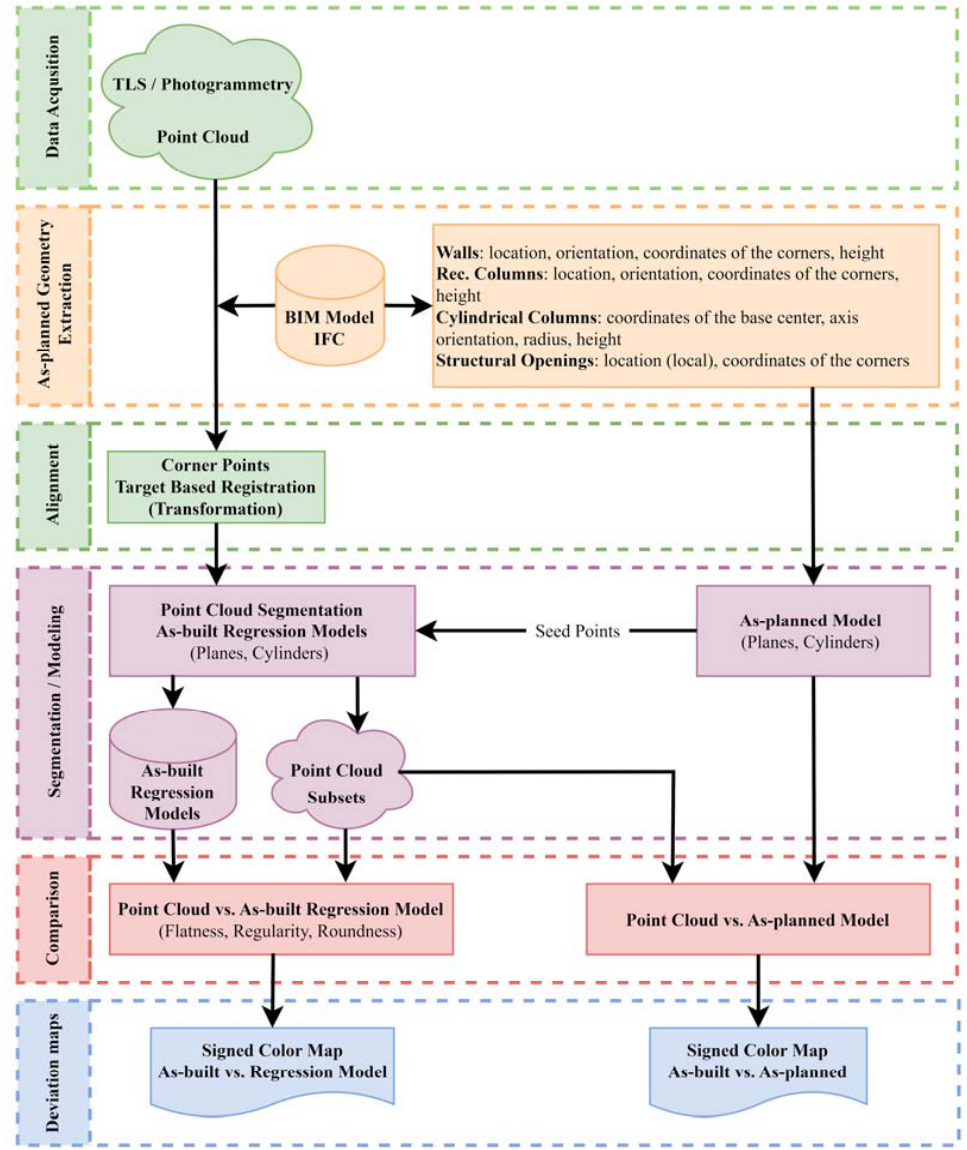
Figure 2. Flowchart of the proposed approach for verification of building structures.